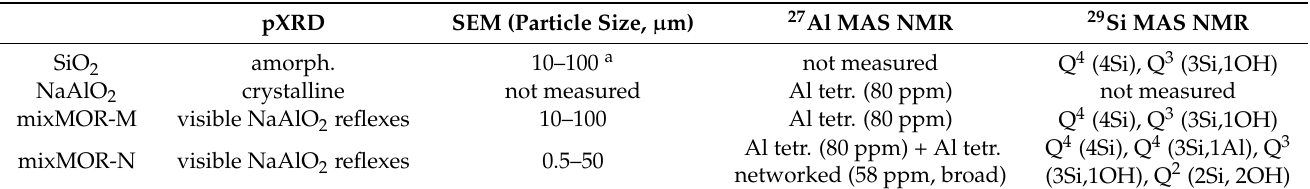
Table 2. Summary of changes in the milled mixtures vs. raw reagents. Milled reagent mixtures notation: mixMOR-M—manual pretreatment, mixMOR-N—planetary milling. (Reprinted with permission from [43]. Copyright: 2019, John Wiley and